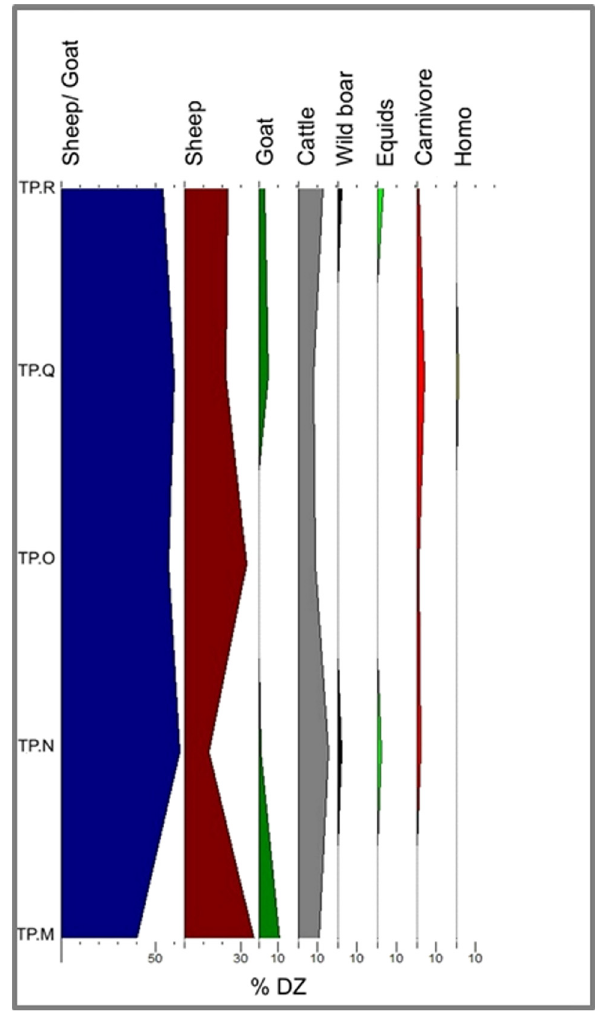
Figure 3: Çatalhöyük East, TP sequence. Proportions of the major taxa by TP levels using diagnostic zones ( DZ )